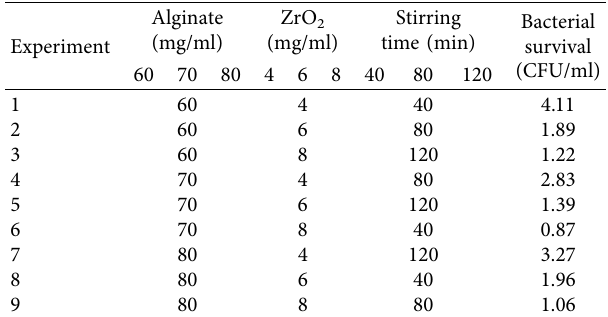
Table 1: Taguchi design of experiments and efects of alginate/ zirconia-synthesized nanocomposites on the survival rate of Streptococcus mutans. Alginate ZrO 2 (mg/ml) (mg/ml) Experiment